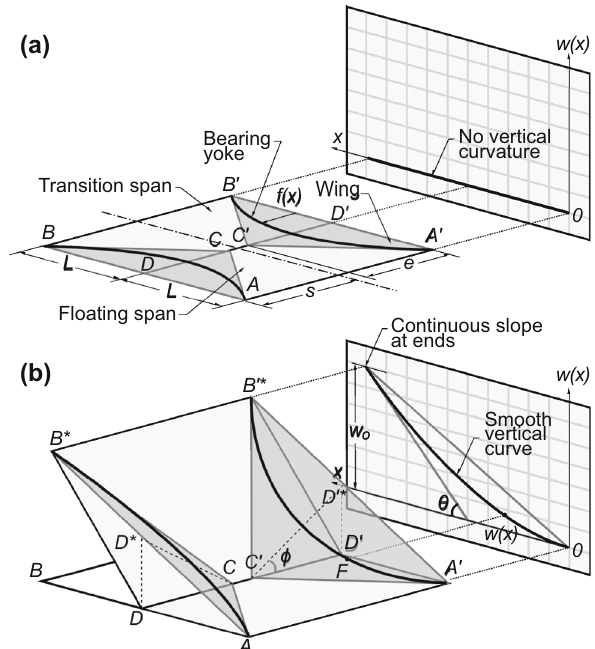
Fig. 6 Geometry for analysis of pitch motions, ( a ) undeformed configuration, ( b ) deformed configuration (rotations are greatly